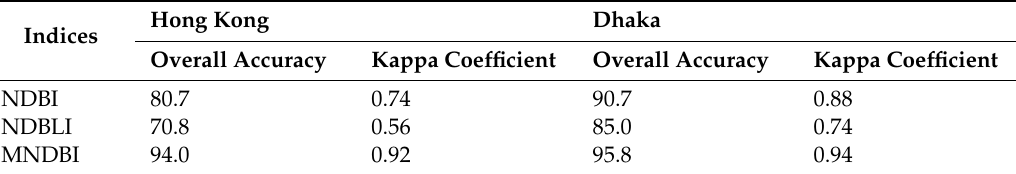
Table 4. Sensitivity of indices in the detection of impervious and bare land.